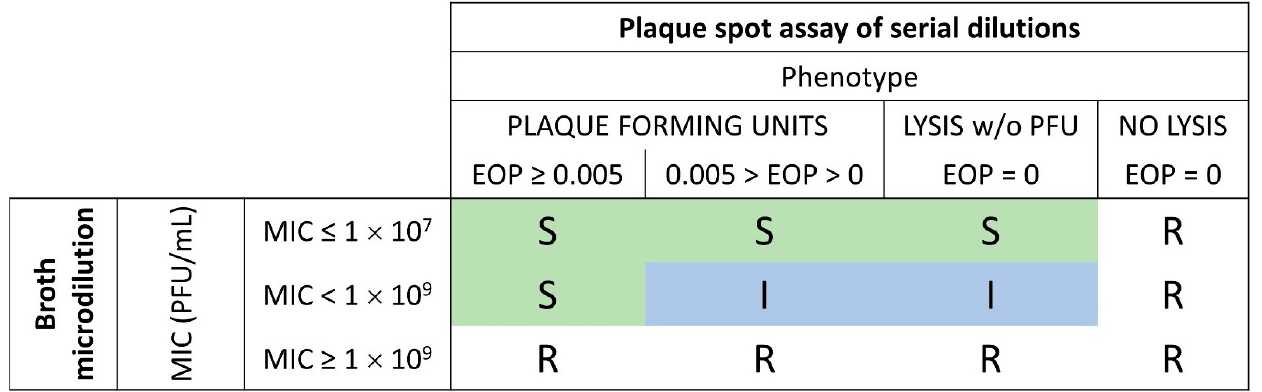
Figure 4. SIR classification based on the MIC and EOP scores: Combining of the EOP and MIC results obtained from phage activity testing methods (Figure 1) and interpretation of the strain susceptibility. The strain was considered as resistant “R” when no lysis was observed on the spot plaque assay or when the MIC was above 1 × 10 9 PFU/mL. The strain was defined as susceptible “S” as long as the MIC was below 1 × 10 7 PFU/mL, and when the MIC was between 1 × 10 7 and 1 × 10 9 PFU/mL with an EOP above 0.005. The strain was defined as susceptible at increased exposure “I” when MIC was between 1 × 10 7 and 1 × 10 9 PFU/mL and an EOP above 0 still 0.005 or when a partial lysis of the spot without PFU was observed on the spot plaque assay.